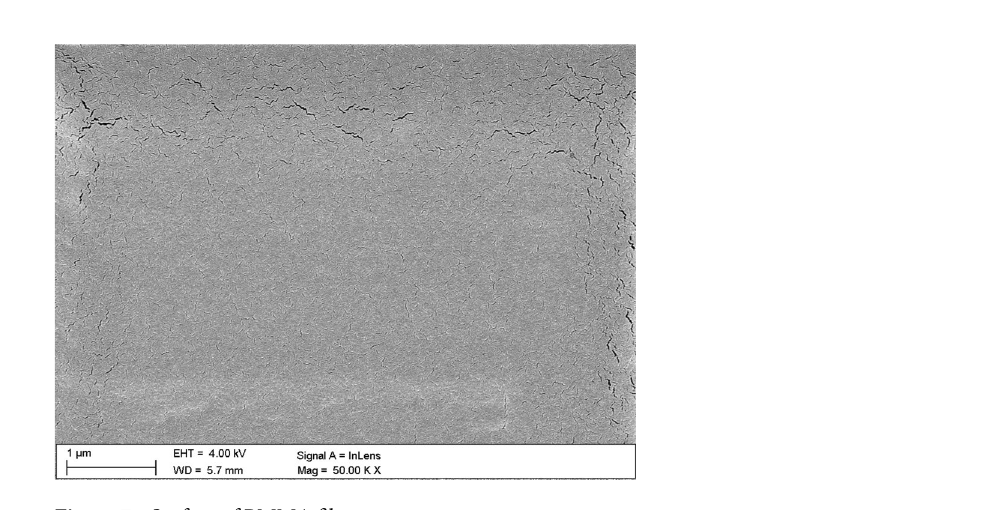
Figure 7. Surface of PMMA